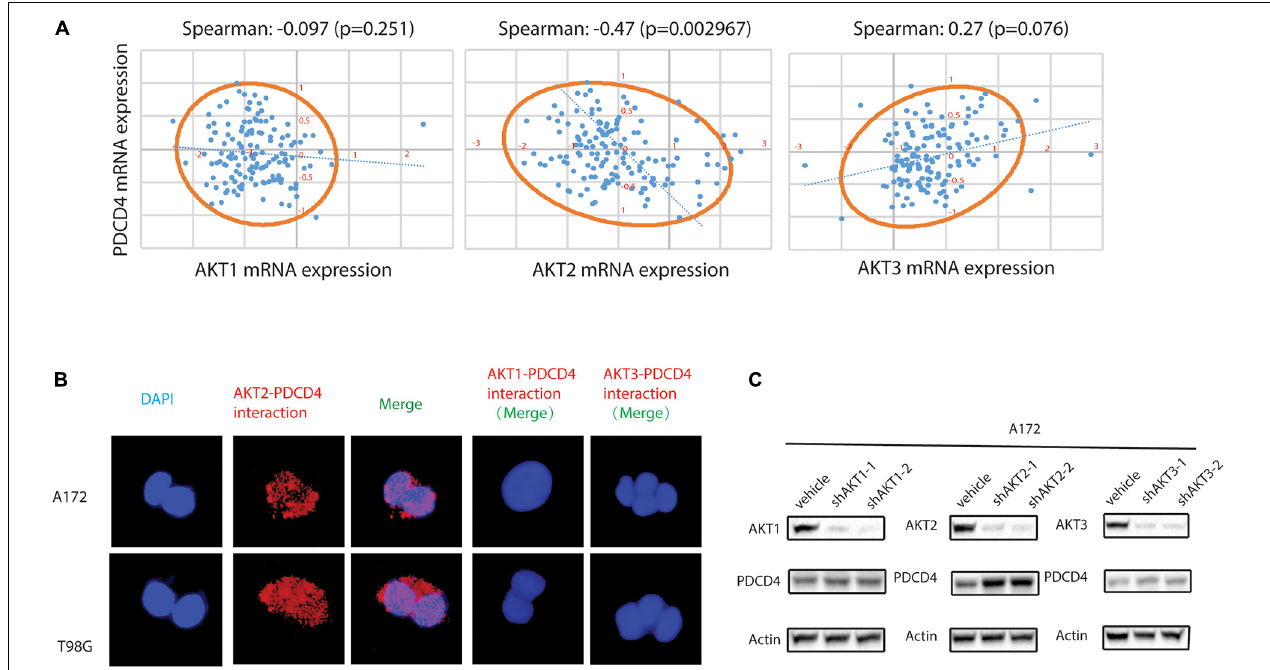
FIGURE 2 | AKT2 interacts with PDCD4 in glioma cells. (A) The association of AKT1, AKT2, or AKT3 mRNA with PDCD4 mRNA. (B) Proximity ligation assay analysis indicating formation of AKT2/PDCD4 complex in glioma cells. (C) Western blot analysis for PDCD4 in glioma cells after knockdown of AKT1 , AKT2 , and AKT3 .